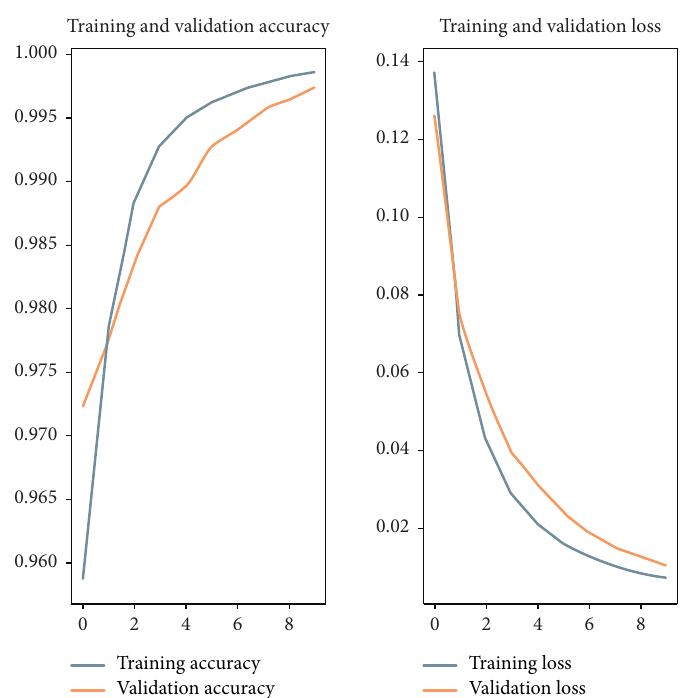
Figure 7: Curve of accuracy and loss value on CNKI CAPTCHA.